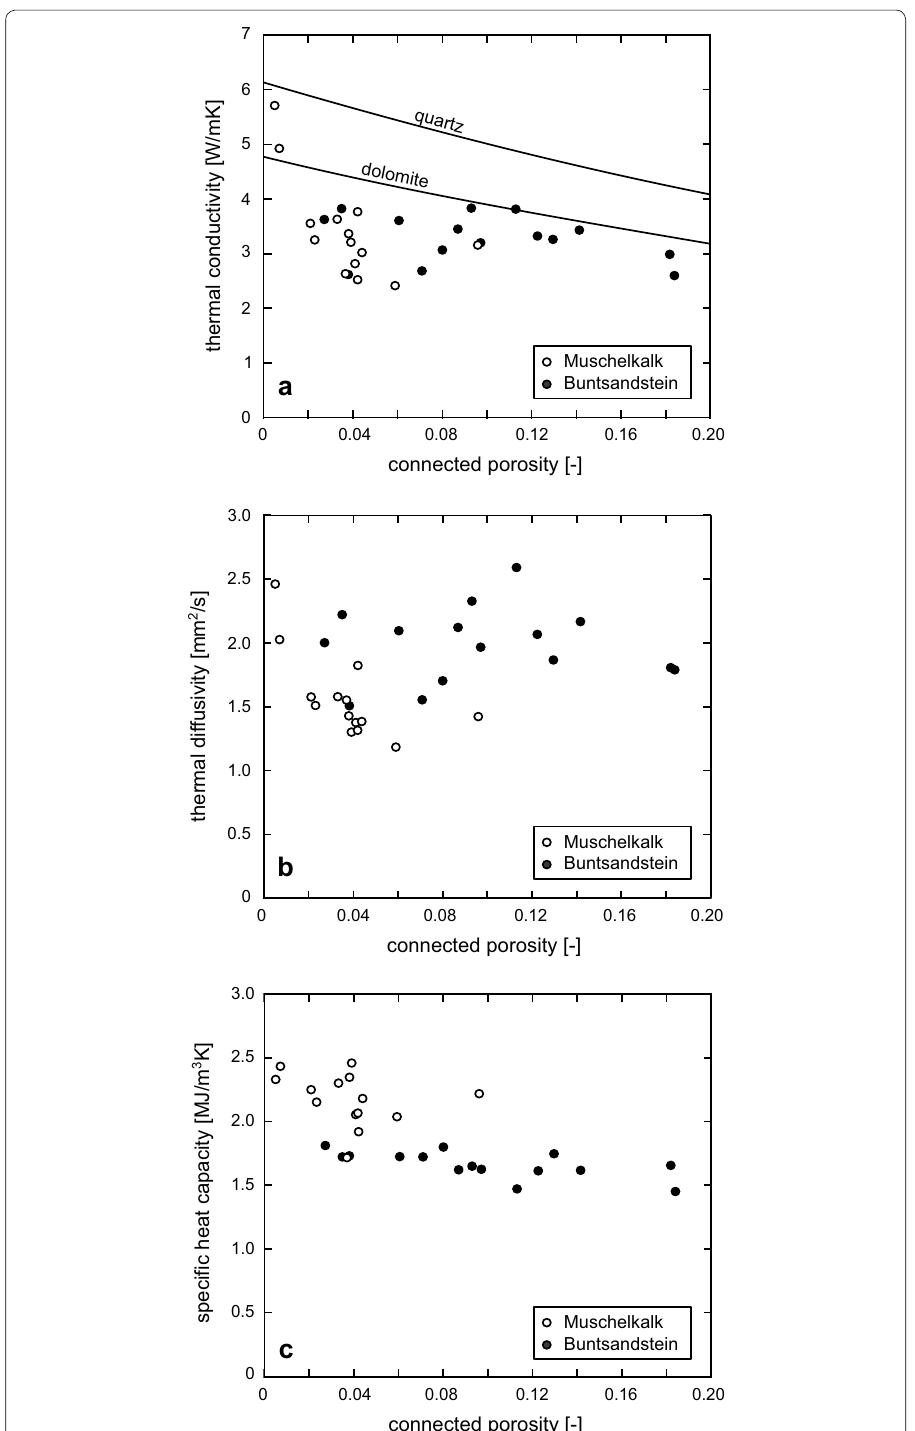
Fig. 11 a Dry thermal conductivity, b dry thermal diffusivity, and c dry specific heat capacity per unit volume as a function of connected porosity for Muschelkalk (white circles) and Buntsandstein (black circles) samples from exploration well EPS-1 (Soultz-sous-Forêts). Thermal conductivity as a function of porosity is modelled for quartz and dolomite using the Rayleigh–Maxwell equation (Eq. (2); see text for